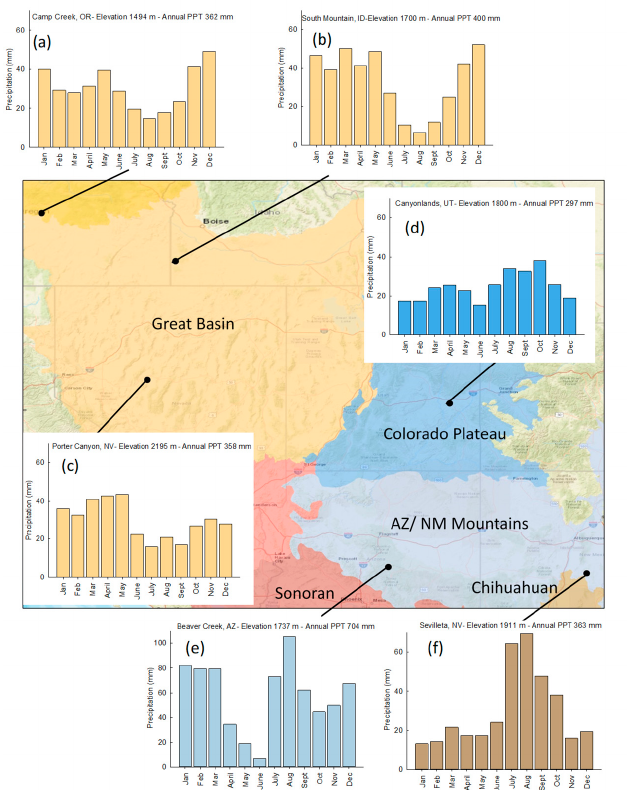
Figure 1. Mean monthly precipitation (PPT) for six selected pinyon ( Pinus spp.) and juniper ( Juniperus spp.) woodland study locations listed in Table 1, inclusive of sites with snow-dominated ( a – c ), mixed phase ( d ), and rainfall-dominated ( e , f ) precipitation regimes and representative of the Great Basin ( a – c ), Colorado Plateau ( d , e ) and southwestern desert regions (southwestern US, ( f )) of Arizona (AZ) and New Mexico (NM), USA. Precipitation from 30-year monthly PRISM data (1981–2010) at 800 m resolution